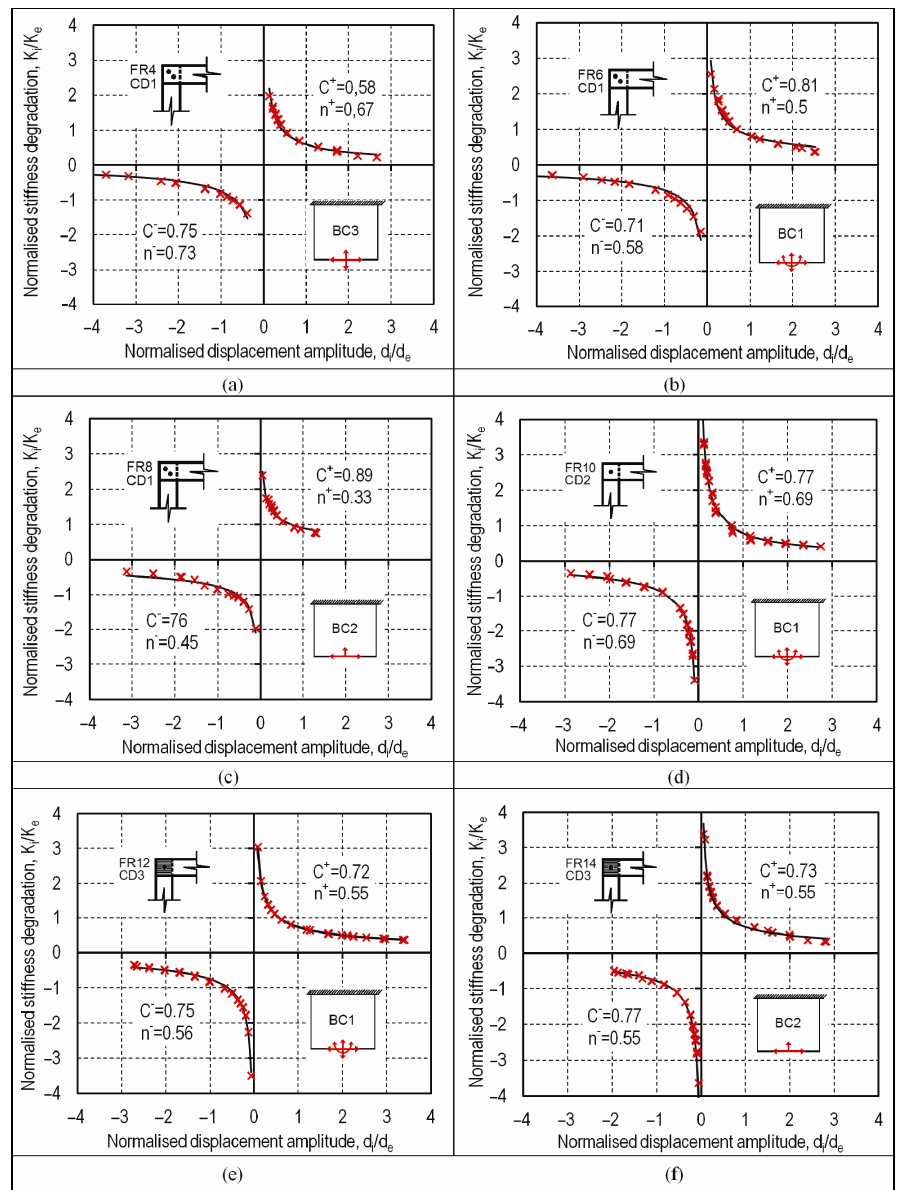
Fig. 8. Normalised stiffness degradation with calculated stiffness degradation characteristic factors C and n for specimens FR4 (a), FR6 (b), FR8 (c), FR10 (d), FR12 (e) and FR14